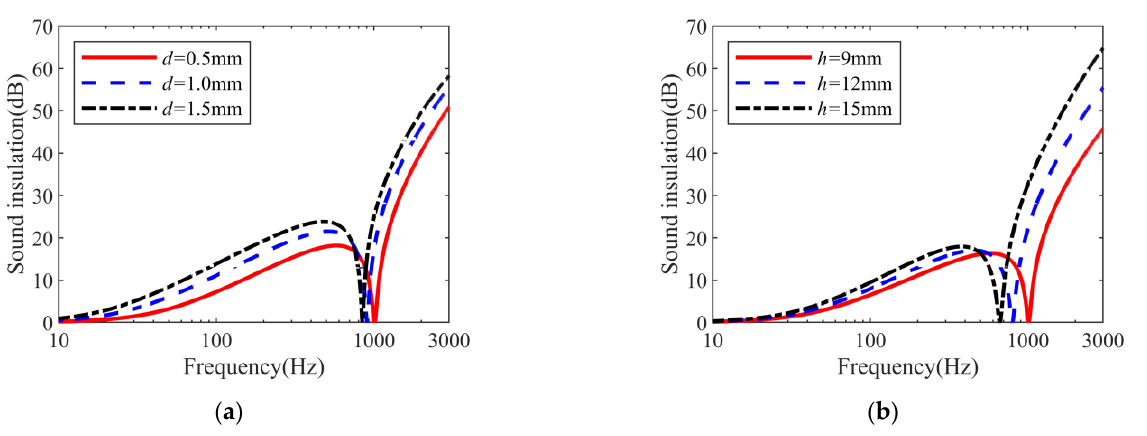
Figure 7. Influence of thickness/height of each layer on sound insulation: ( a ) panel thickness, ( b ) core layer height. ( b ) core layer